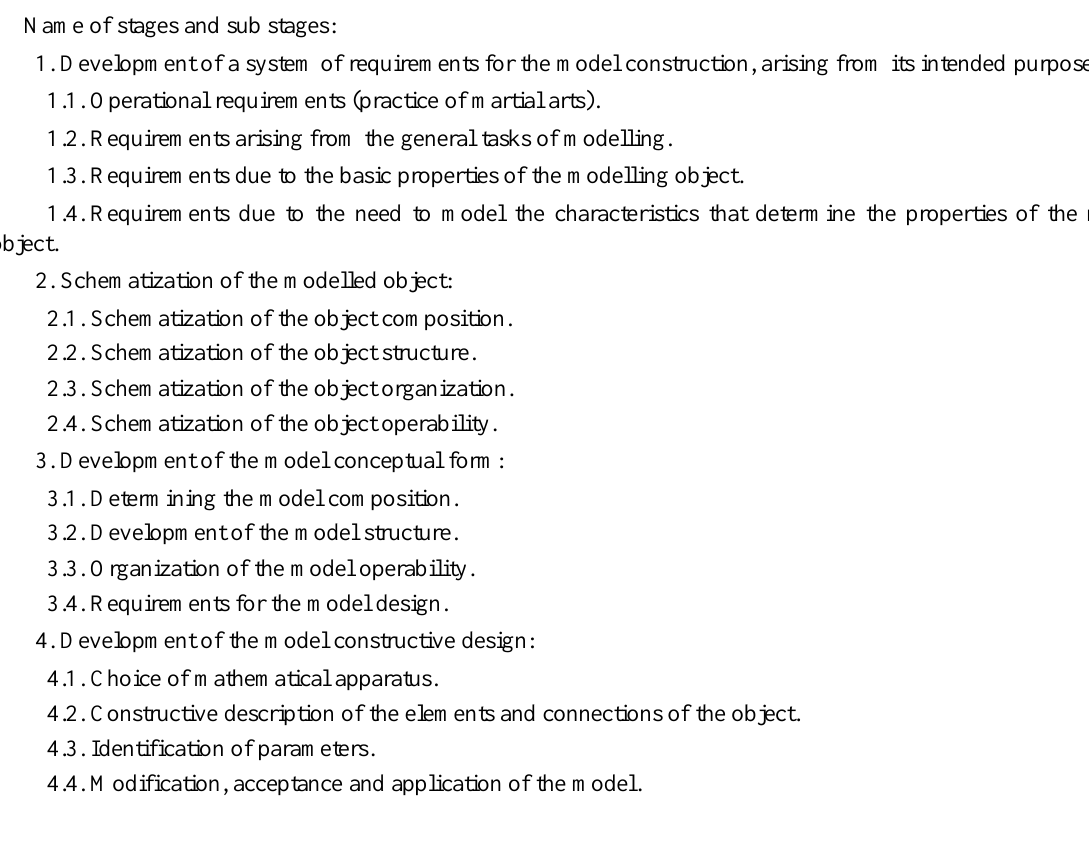
Figure 3. The relationship between the structural components of the model